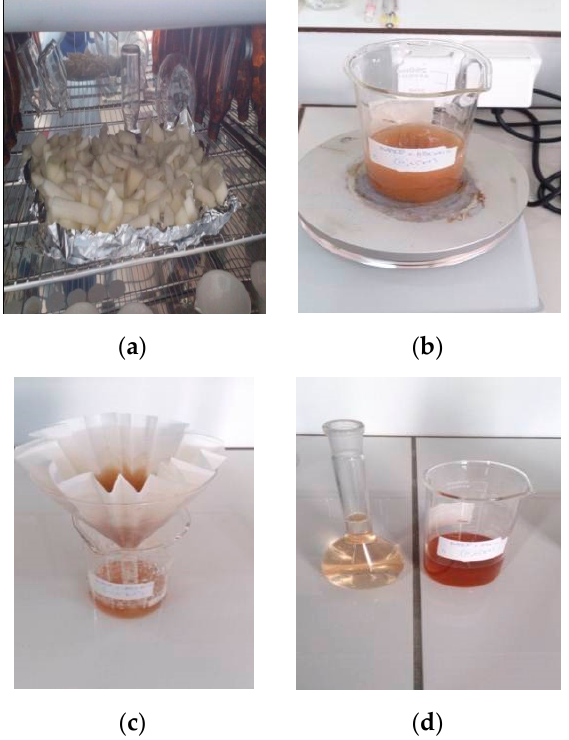
Figure 2. Preparation of the bio-coagulant: ( a ) drying at T < 50 °C; ( b ) mixing for 20 min; ( c ) filtering; ( d ) extracting.